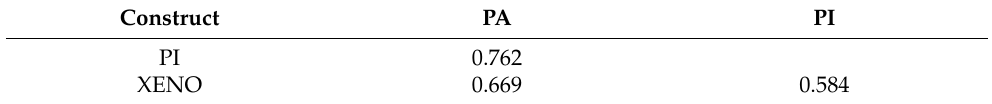
Table 7. Discriminant validity—Heterotrait–Monotrait ratio (HTMT).